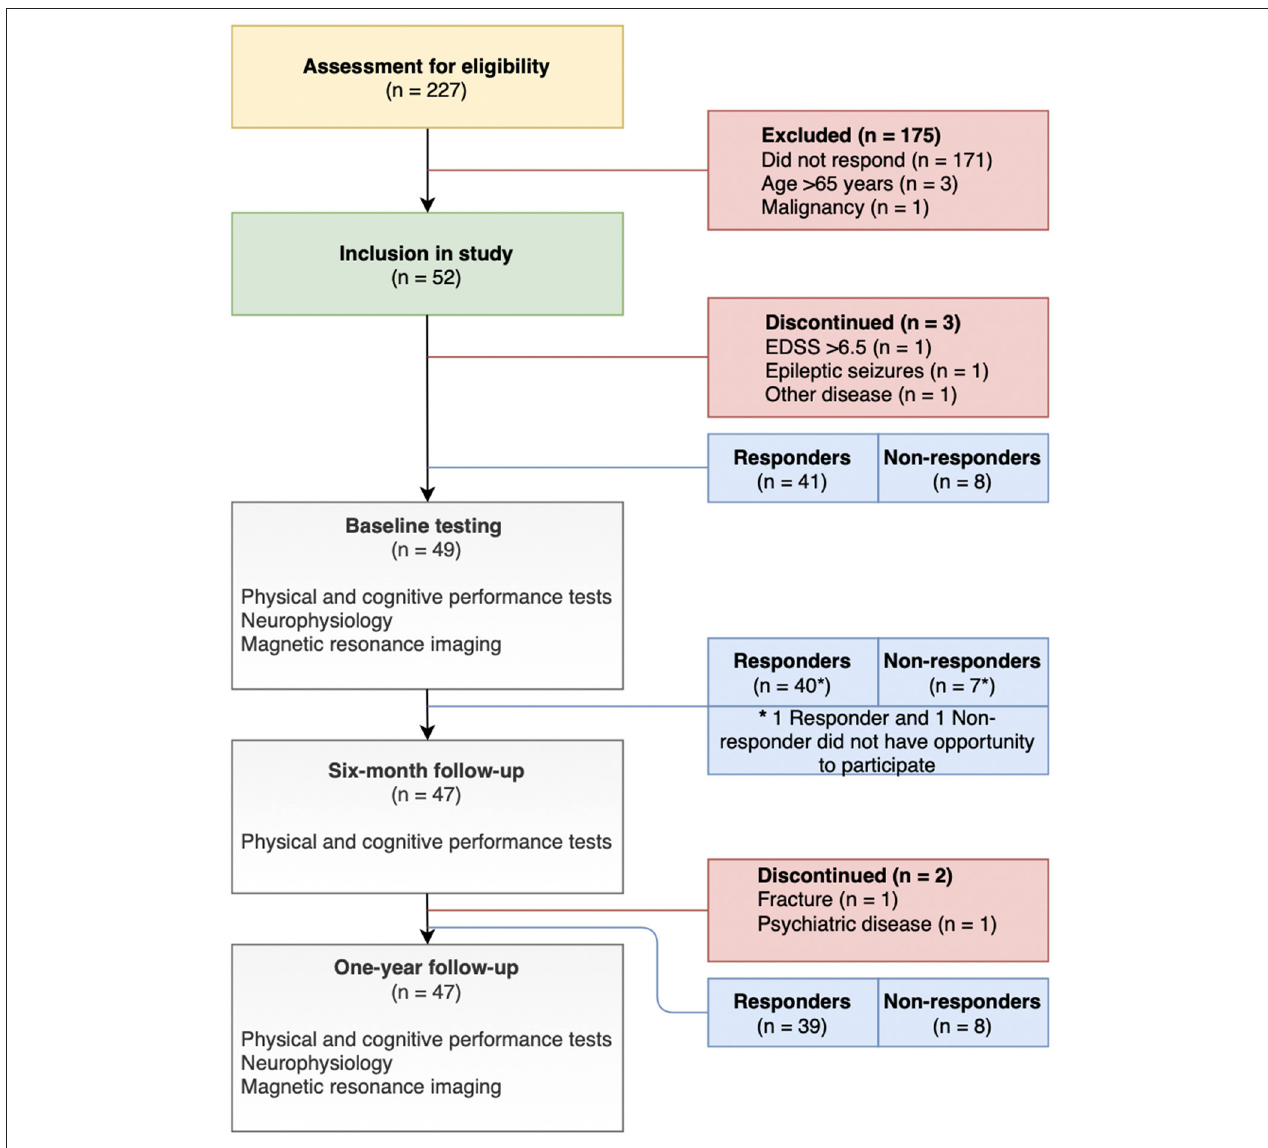
FIGURE 2 | Flowchart of study design and participant selection.